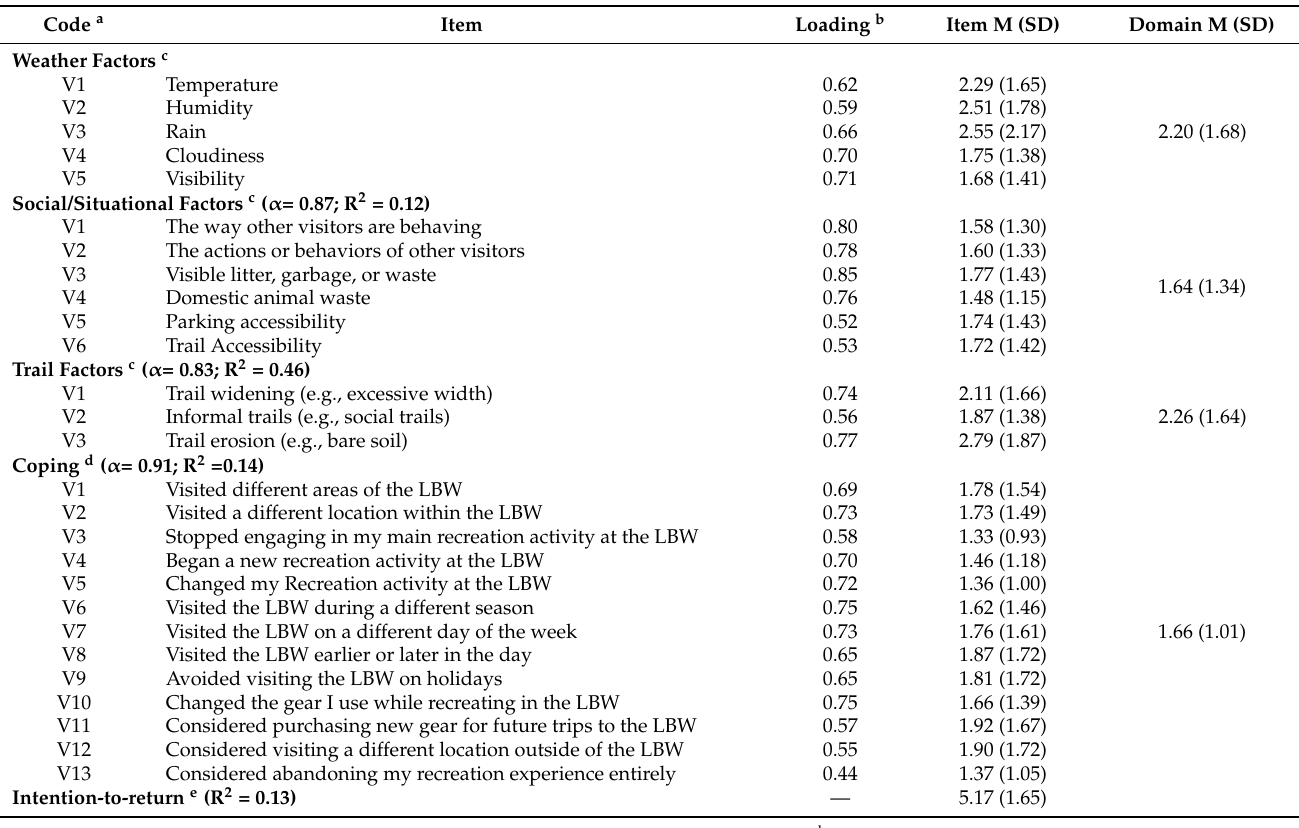
Table 6. LBW Confirmatory Factor Analysis for the Structural Equation